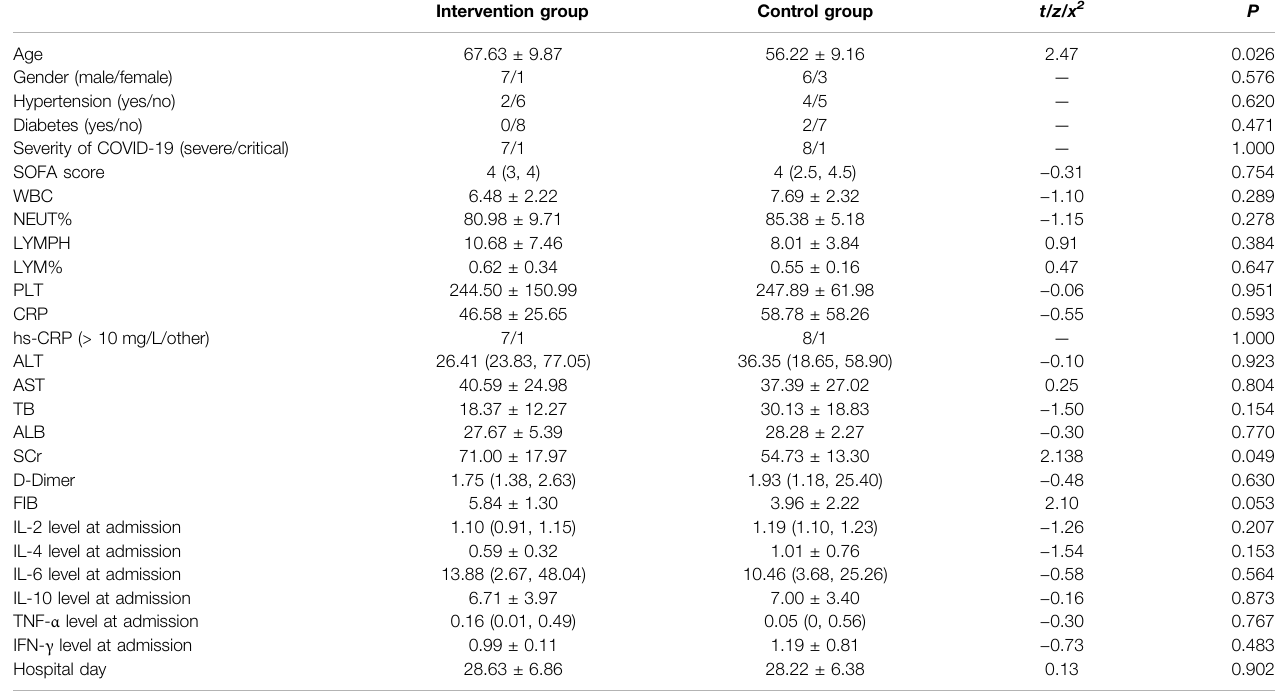
TABLE 1 | Comparison of demographic and clinical baseline data between the two groups.